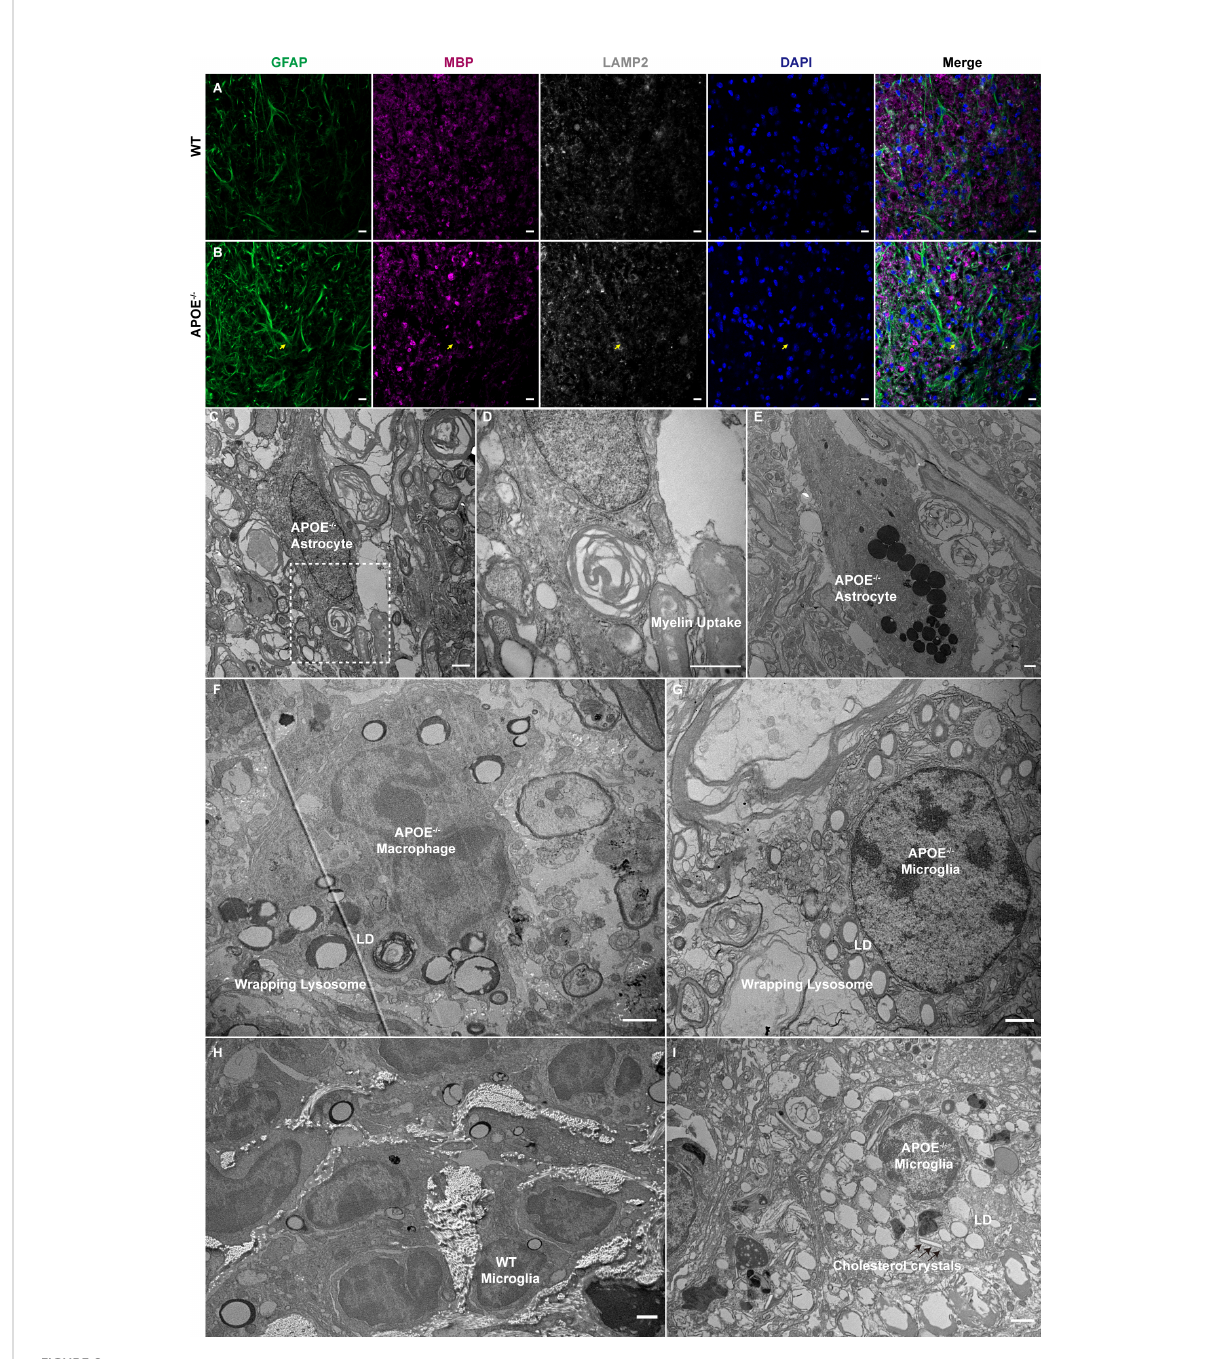
FIGURE 8 Myelin uptake in astrocytes and lipid droplets and lysosome accumulation in macrophages and microglia in APOE -/- mice following spinal cord injury (SCI). (A, B) Myelin debris was engulfed by astrocytes in the lesion rim of APOE -/- mice six weeks post injury (wpi) (yellow arrows). Green, GFAP; purple, MBP; white, LAMP2; blue, DAPI. (C, D) Transmission electron microscopy (TEM) images of astrocytes in APOE -/- mice six wpi con fi rmed that the hypertrophic astrocytes contained degraded myelin debris. The boxed area is shown in (D) at higher magni fi cation. (E) TEM image of astrocytes in APOE -/- mice six wpi shows markedly elevated lysosomes. (F, G) TEM image of macrophages and microglia in APOE -/- mice taken seven days post injury (dpi) shows increased number of lipid droplets and dense lysosome material. (H) Representative image of microglia in wild-type (WT) mice 16 wpi. (I) TEM image of microglia in APOE -/- mice 16 wpi shows markedly elevated lipid droplets and the formation of needle-like cholesterol crystals (black arrows). LD, lipid droplets. Scale bar (A, B) = 10 µm. Scale bar (C – I) = 1